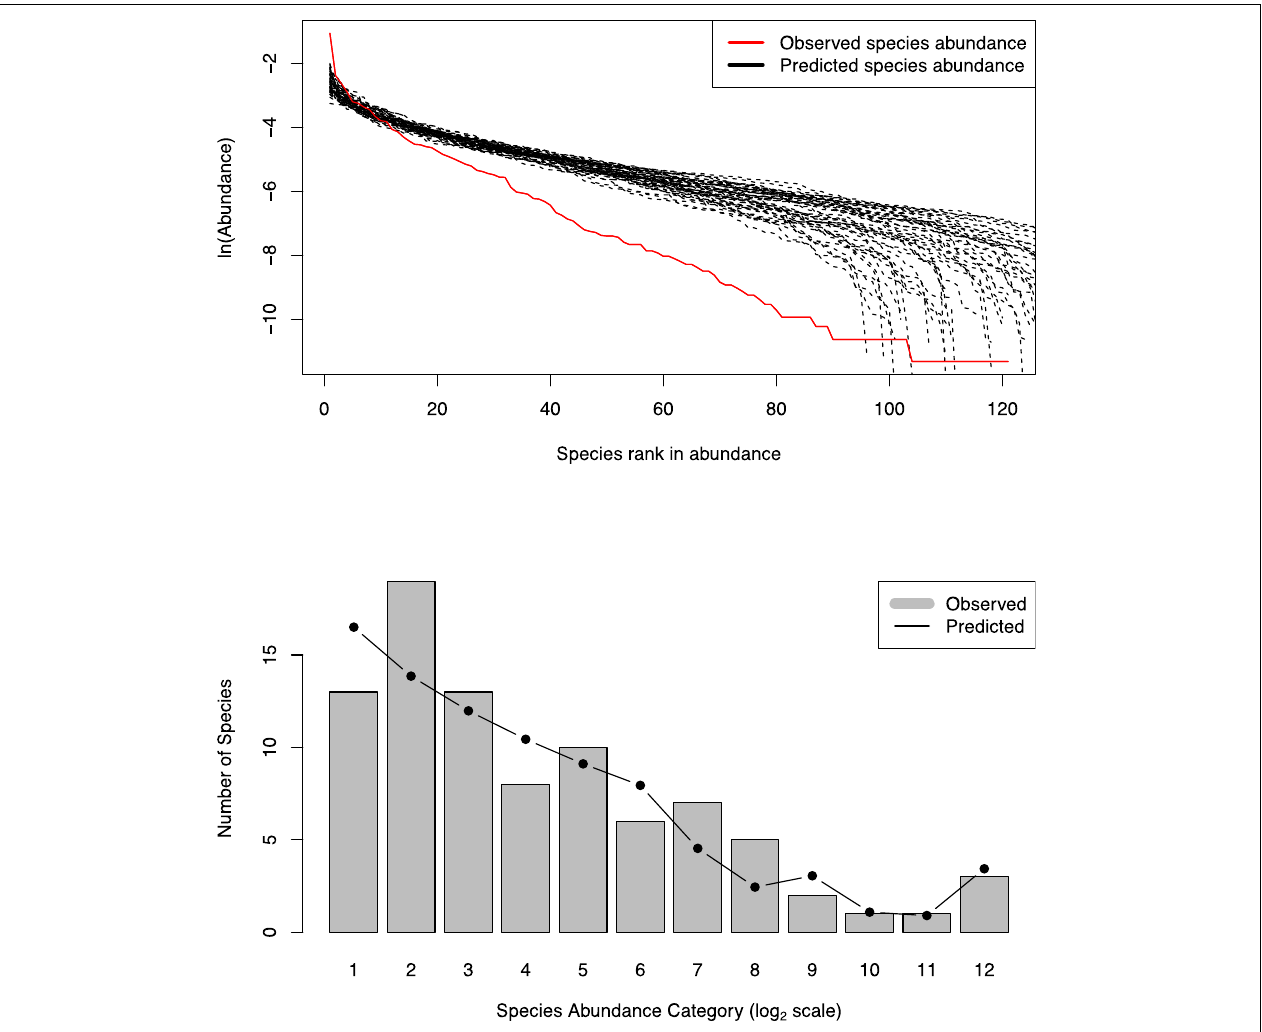
FIGURE 1 | Examples showing the fittings of the MSN and NNH models to DT microbiomes: ( i ) the top graph from # 275 re-sampling showing a failed fitting to MSN model; ( ii ) the bottom graph from # 1 re-sampling showing a successful fitting to NNH model.